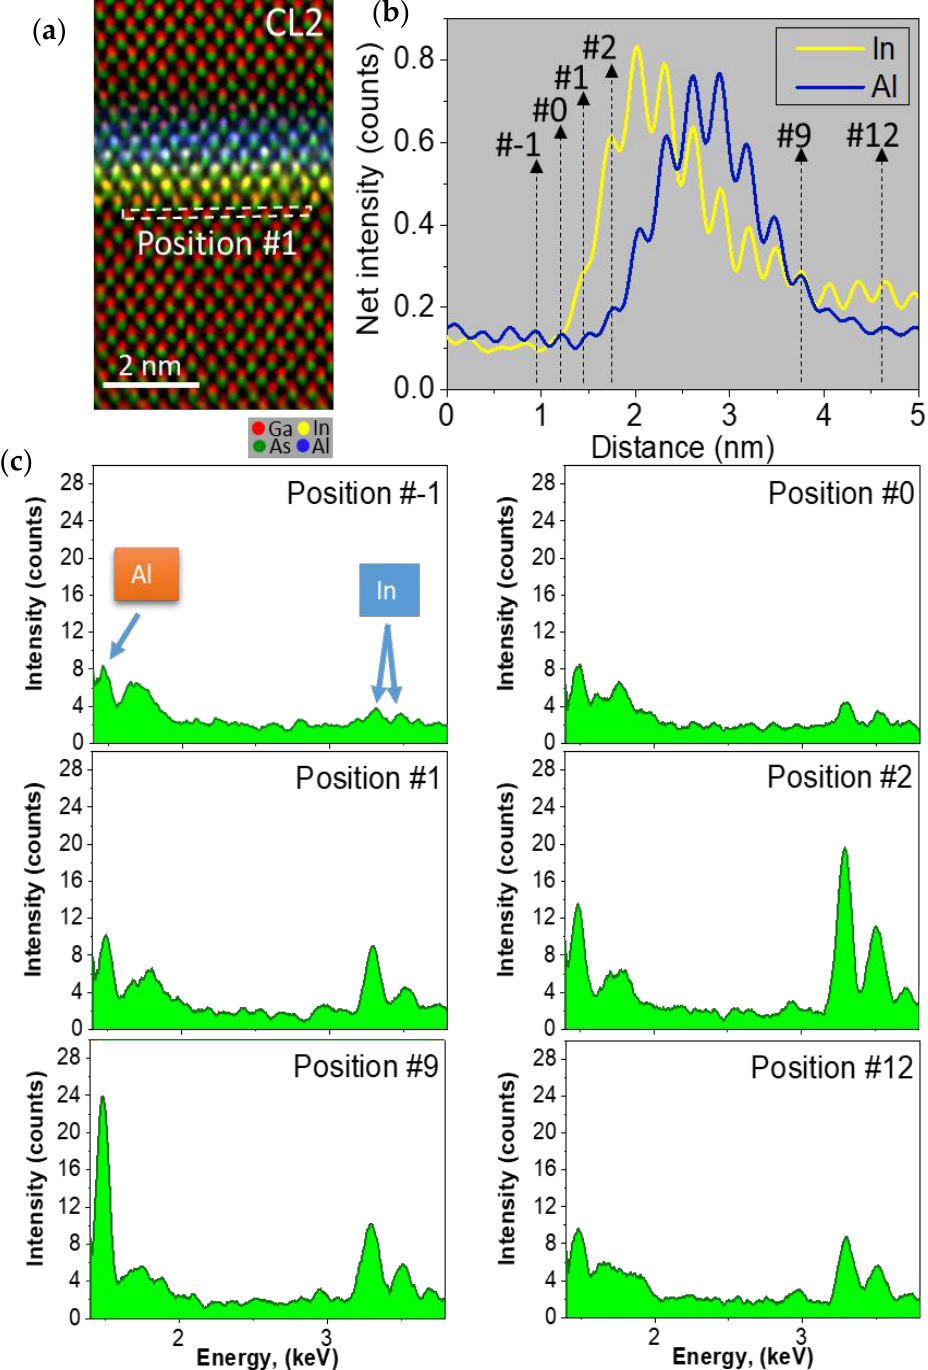
Figure 5. For the WL of CL2, ( a ) EDX map showing the distribution of Ga, In, As, and Al. A rectangular ROI is showed at position #1 ( b ) Net counts profiles for In and Al along the growth direction. ( a , c ) EDX spectra for ROI displacements along the growth direction in position # − 1, #0, #1, #2, #11, and #12. Spectra of 4096 points in length were smoothed on the graph using Savitzky-Golay algorithm using a 30-point window to remove some background